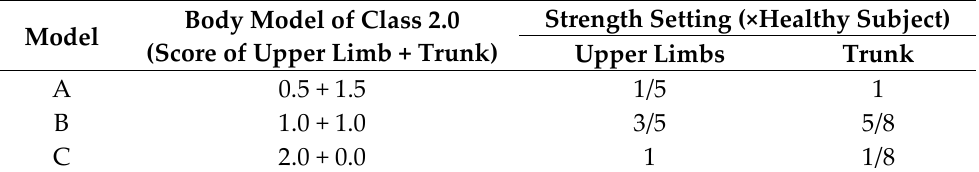
Table 1. Strength setting by muscular dysfunction.